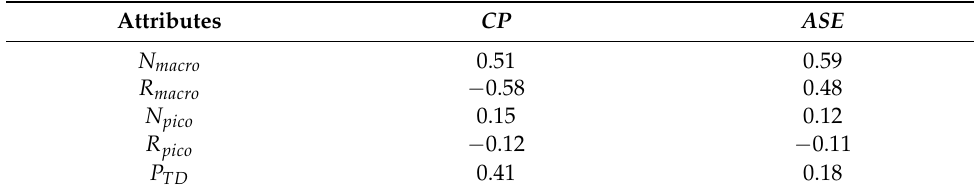
Table 3. Correlation